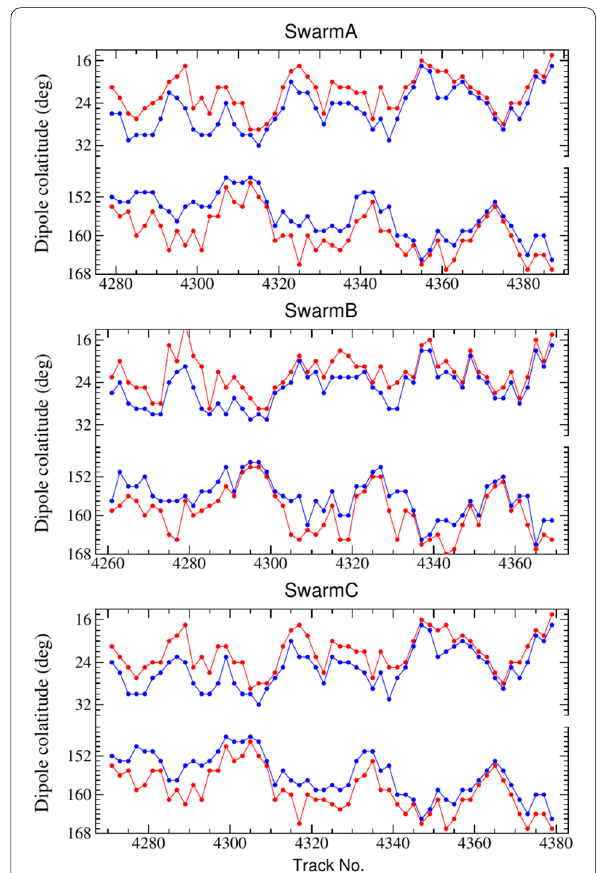
Fig. 8 The colatitudinal positions of Region 1 (red) and Region 2 (blue) of the northern (top part of each panel) and southern (bottom part of each panel) polar ovals for the magnetic storm analysed in Fig. 1. The Region 1 and Region 2 colatitudes were estimated by analysing residual signal (cid:31) Y sm along Swarm A (top panel), Swarm B (middle panel) and Swarm C (bottom panel) tracks,